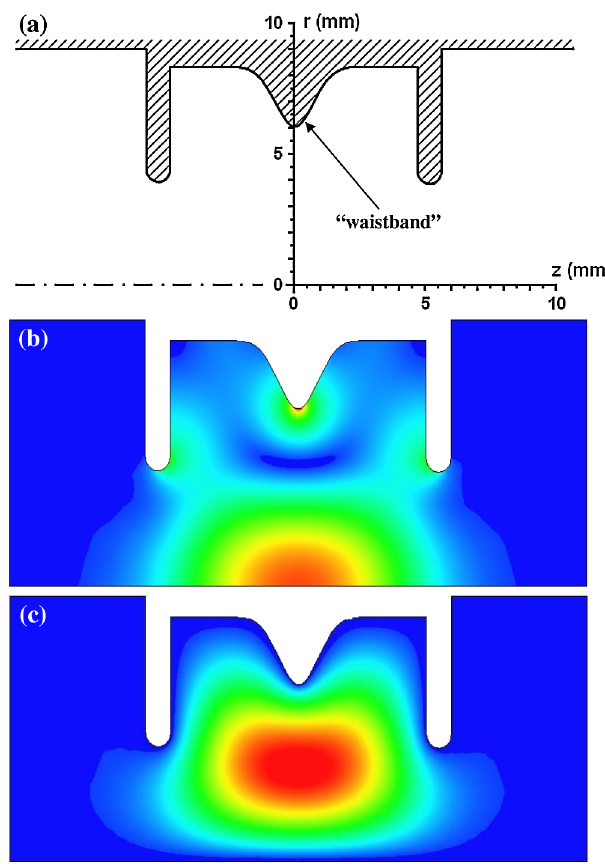
FIG. 3. (a) Scheme of the test cavity with the results of 3D simulation of (b) magnetic and (c) electric fields.